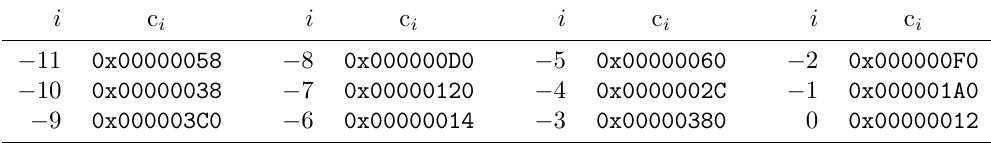
Table 2: The round constants c i with − 11 ≤ i ≤ 0, in hexadecimal notation (the least significant bit is at z =